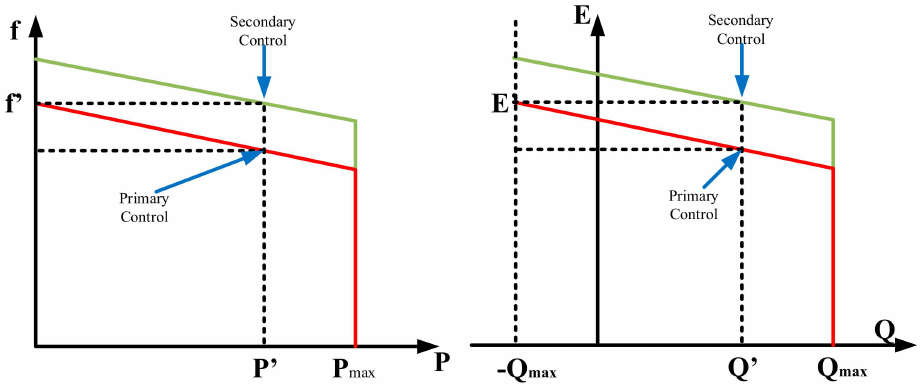
Figure 7. Characteristics of primary and secondary control methods